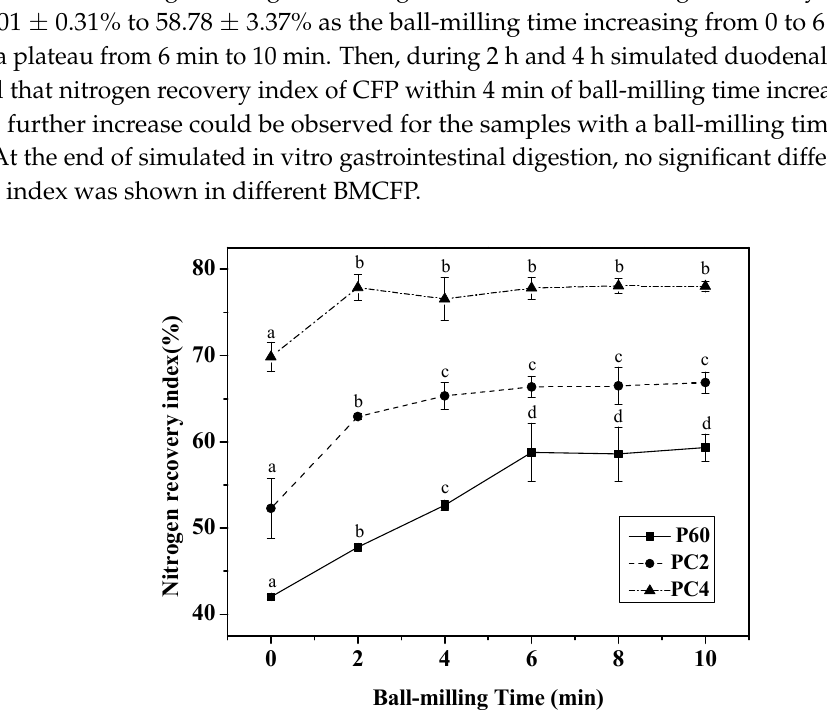
Figure 5. Effects of ball-milling time (0, 2, 4, 6, 8, and 10 min) on nitrogen recovery index simulated gastro duodenal digestion of CFP. Three curves, 60 min (P60) of gastric digests, 2 h (PC2), and 4 h (PC4) of gastro duodenal digests (60 min of gastric followed by 4 h of duodenal digestion), were showed digestibility of BMCFP during gastro duodenal digestion. p < 0.05.